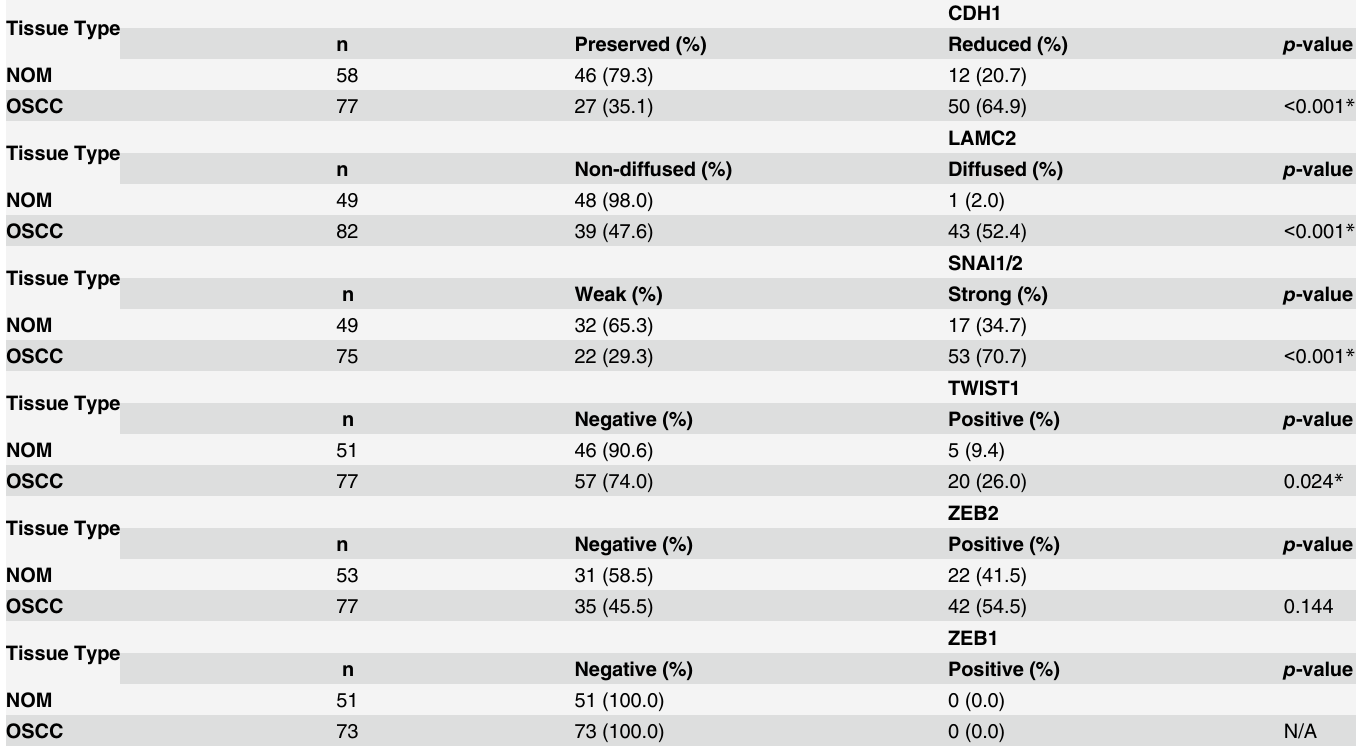
Table 2. Differential expression of EMT-related proteins in non-malignant and OSCC tissues. Tissue